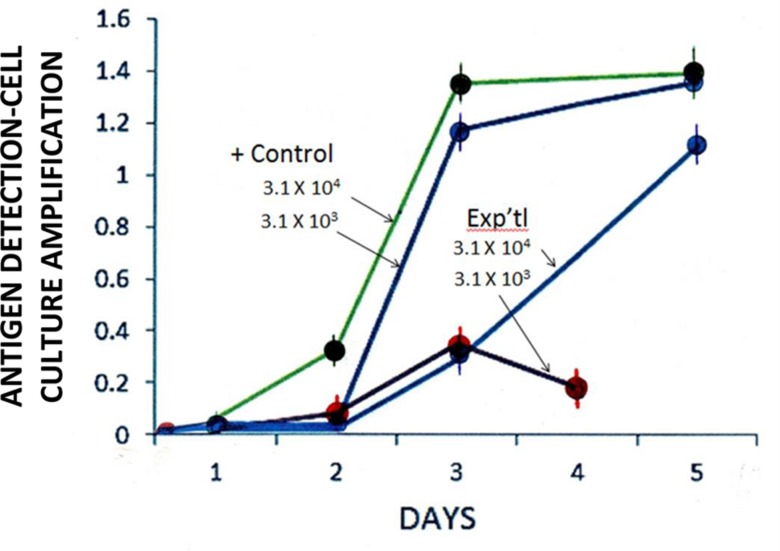
Effect of GH (100 × 103 μg/ml) on the isolation [antigen detection-cell culture amplification (Ag-CCA)] of RTV in MA-104 cell culture monolayers. Input titers: 3.1 × 103 to 3.1 × 104 TCID50/ml. Day 2 experimental (3.1 × 104) vs. Positive control (3.1 × 104 TCID50/ml): p = 0.08 (n = 3). Spectrophotometric readings performed at 450 nm. Data points represent the mean ± SE of the mean. P < 0.05 was assumed statistically significant.